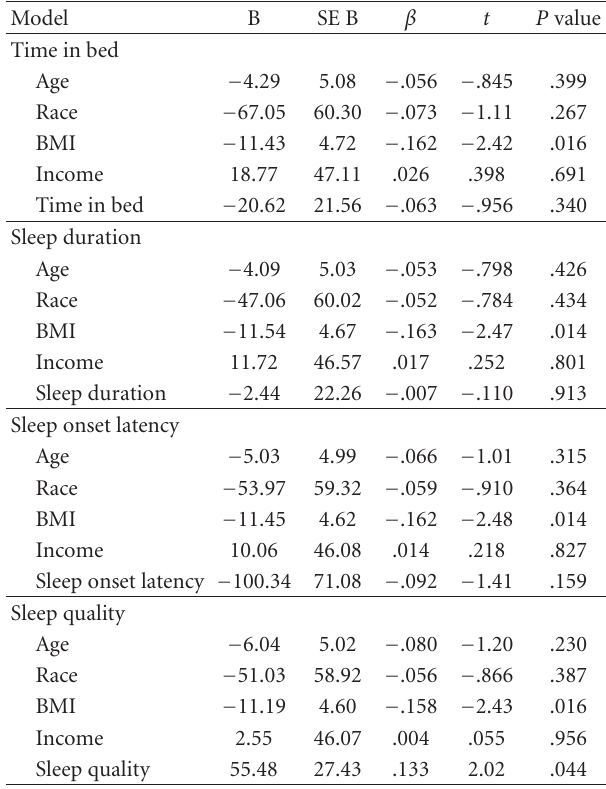
Table 2: Linear regression models displaying associations of sleep variables with telomere length (base pairs) adjusting for study